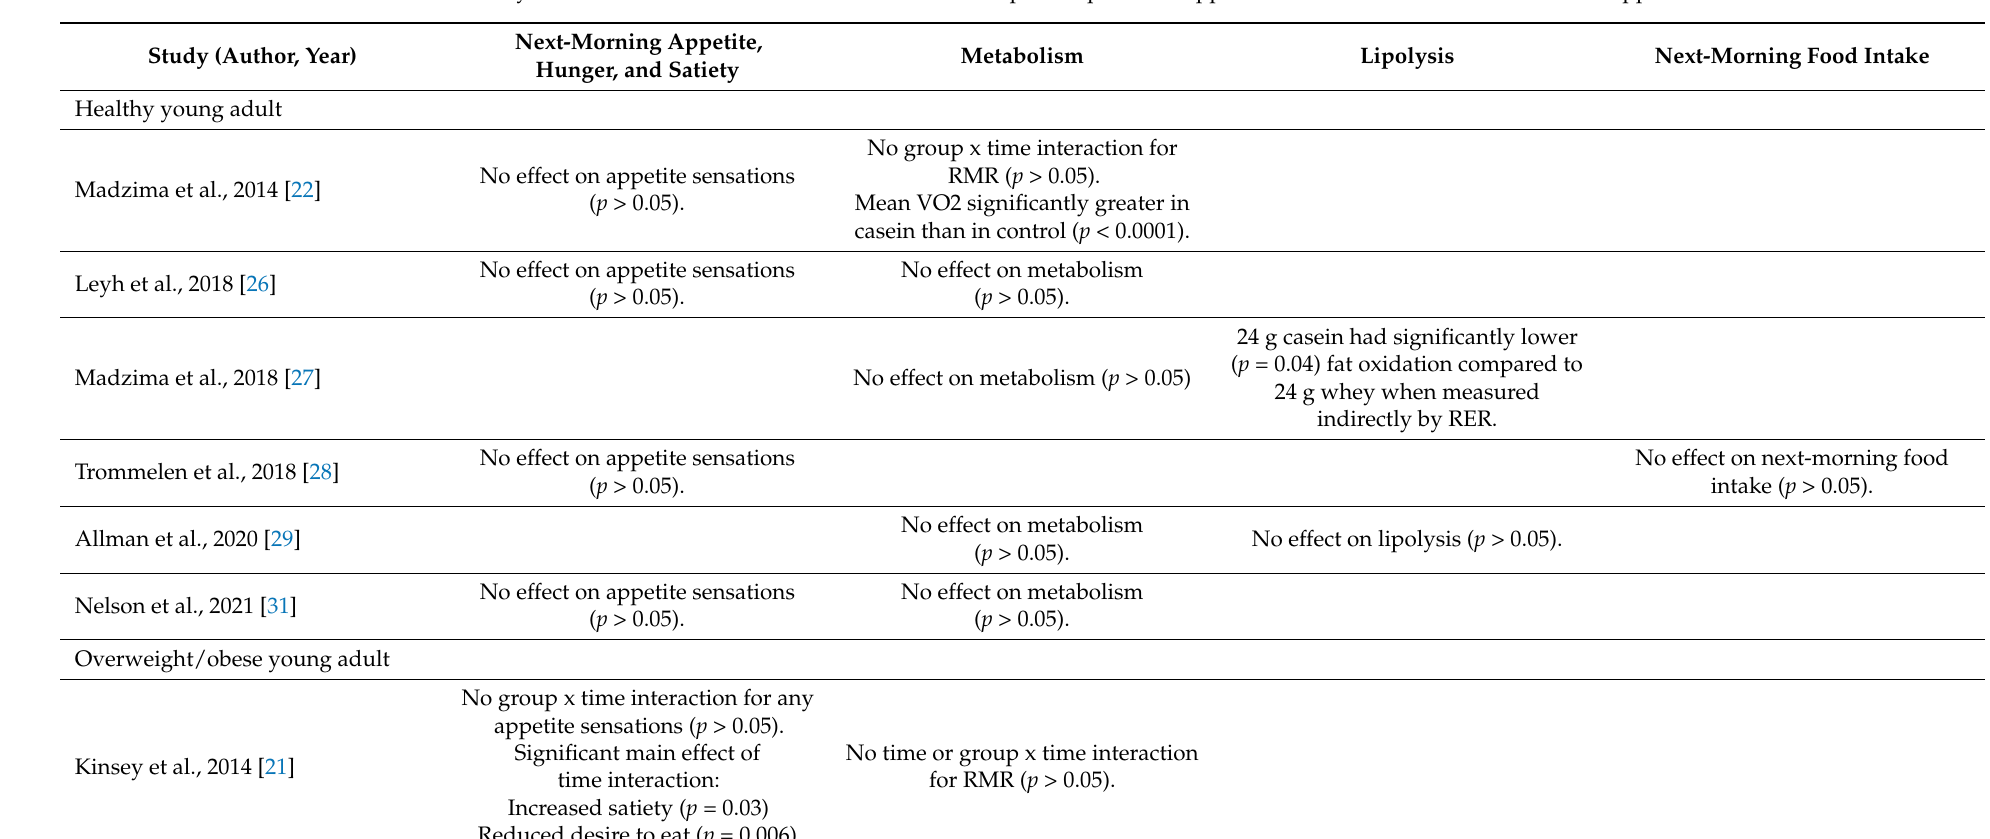
Table 4. Summary of main results from included studies related to pre-sleep casein supplementation effects on metabolism and